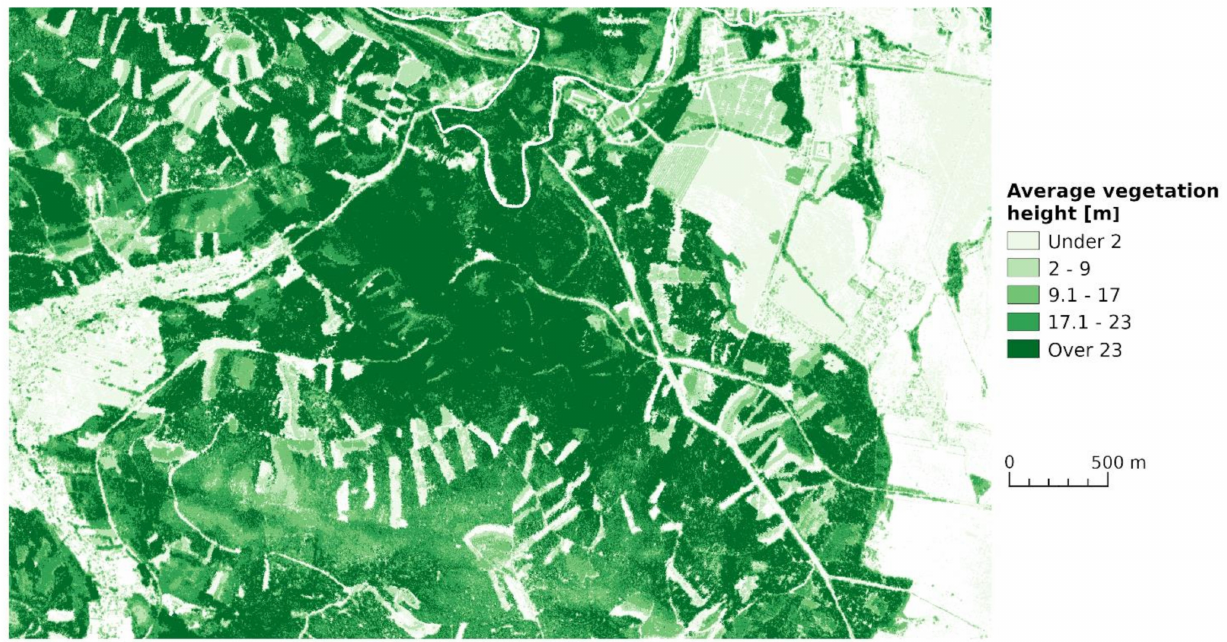
Figure 4. Example of average forest tree stand heights.